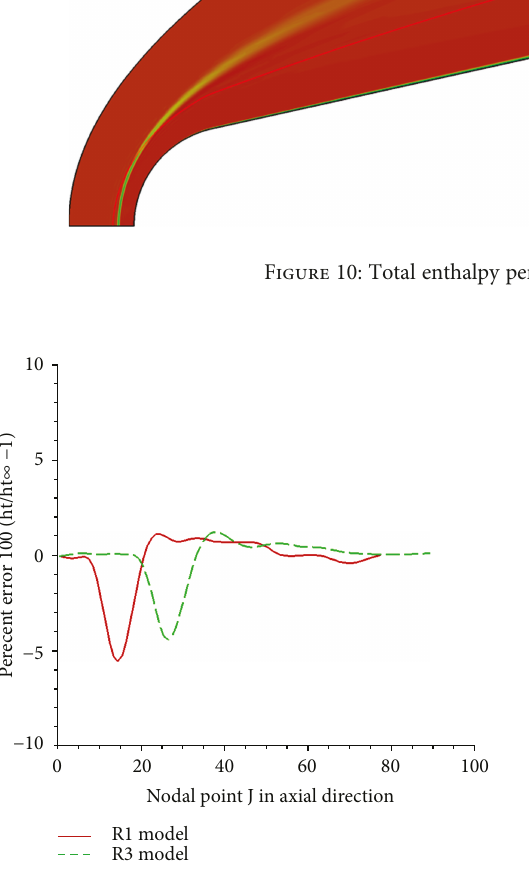
Figure 11: Total enthalpy % error at a normal station k = 92 from the surface.